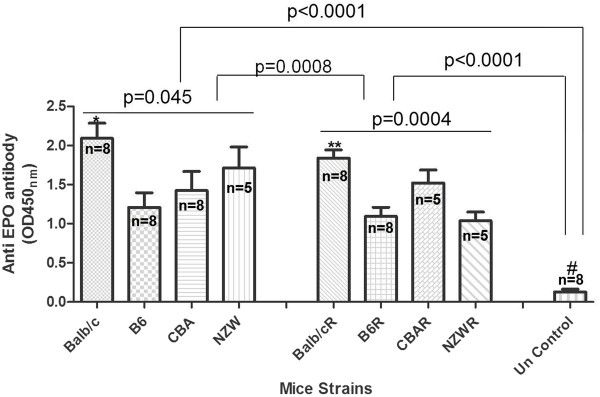
Levels of anti-EPO antibody in the semi-immune mice at infection and recovery. These are anti-EPO antibody level at infection and recovered (R). Blood was harvested for serum at minimum Hb (i.e. maximum Hb reduction, at infection) and recovery (when parasitaemia is cleared). Means of Anti-EPO Ab at infection and recovery differed, p = 0.045 and 0.0004 respectively. *Balb/c values significantly higher when compared with B6 (p < 0.05). **Balb/c values at recovery different from B6 and NZW (p < 0.05). #Significantly lower when compared with the others at infection and recovery (p < 0.0001). Values at infection and recovered differed (p = 0.0008). Recovery refers to time at which mice has been rested for two weeks after treatment with chloroquine/pyrimethamine for 6 days or until parasitaemia is zero. Values are means and errors bars being standard deviation (SD). Data was analysed by ANOVA after they were log10 transformed. n refers to number of samples. These are pooled data of two separate experiments. Un Control means uninfected control (consist of 2 mice per strain, giving a total of 8 mice).